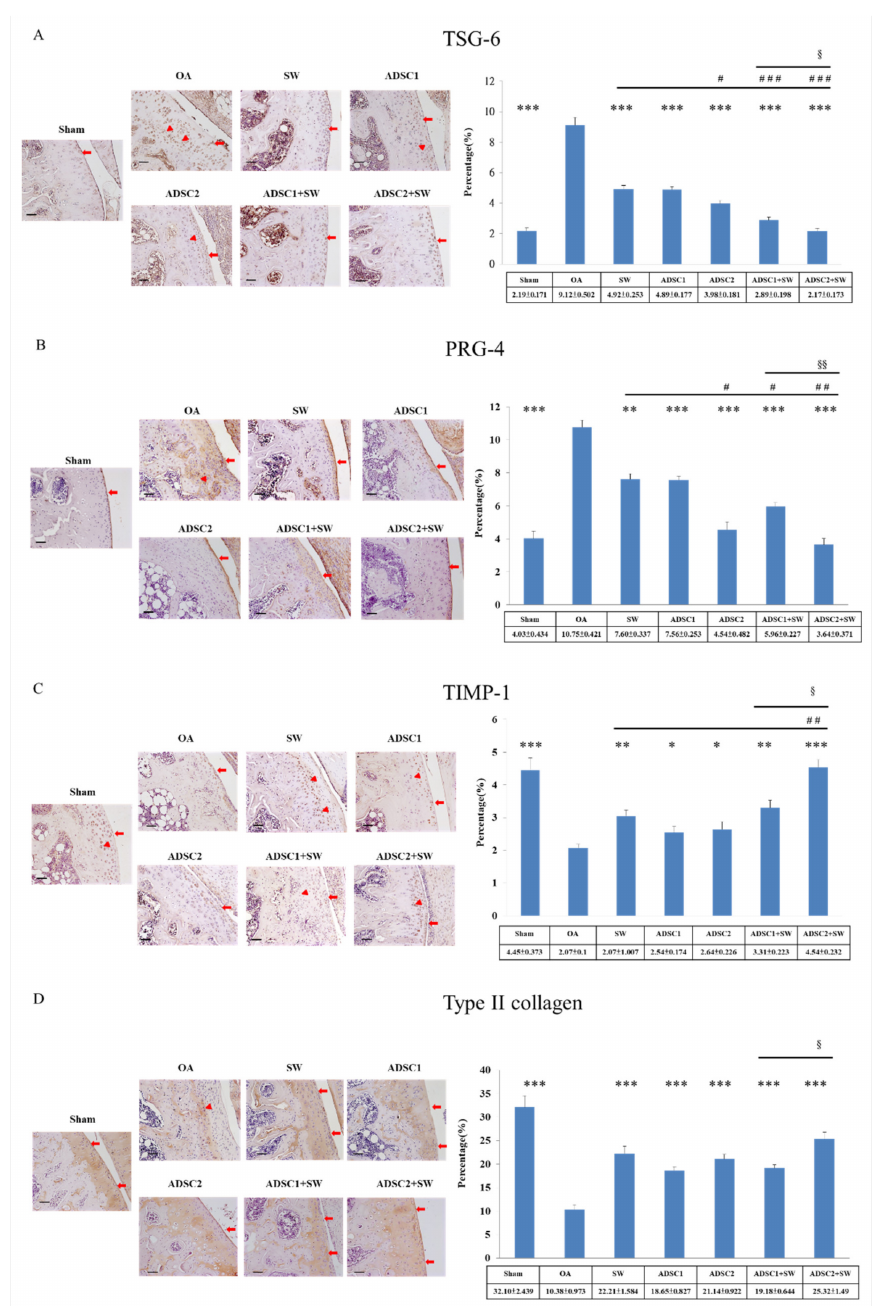
Figure 4. The changes in extracellular matrix factors in the articular cartilage of the OA rat knee after treatment. ( A ) TSG-6, ( B ) PRG-4, ( C ) TIMP-1, and ( D ) Type II collagen were measured in the articular cartilage of the tibia after treatments. The expression percentages were displayed on the left of the images. * p < 0.05, ** p < 0.01, and *** p < 0.001 as compared with the OA group. # p < 0.05, ## p < 0.01, and ### p < 0.001 as compared with the SW group. § p < 0.05, and §§ p < 0.01 as compared with ADSC1 + SW and ADSC2 + SW groups. The images were shown at 200 × magnification. The scale bar was 50 µ m. The triangle was indicated deep region, and the arrowhead was indicated cartilage surface. n = 6 rats in each